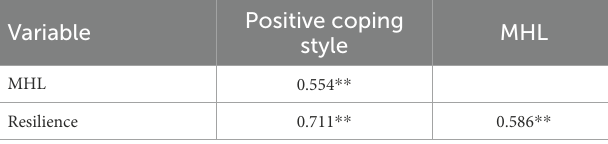
TABLE 3 Correlations among MHL, positive coping style and resilience. Variable